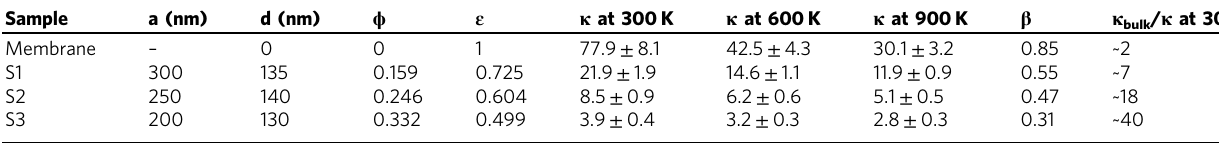
Table 1 Characteristic sizes, coef fi cients and example experimental data for the porous membranes and the 250 nm silicon membrane: a — lattice spacing, d — hole diameter, ϕ — fi ling fraction, ε — volume reduction factor, κ — thermal conductivity (W m − 1 K − 1 ).